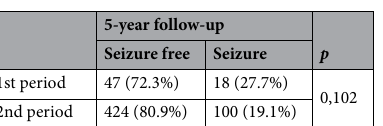
Table 7. Postoperative outcome analysis between the 1st and 2nd